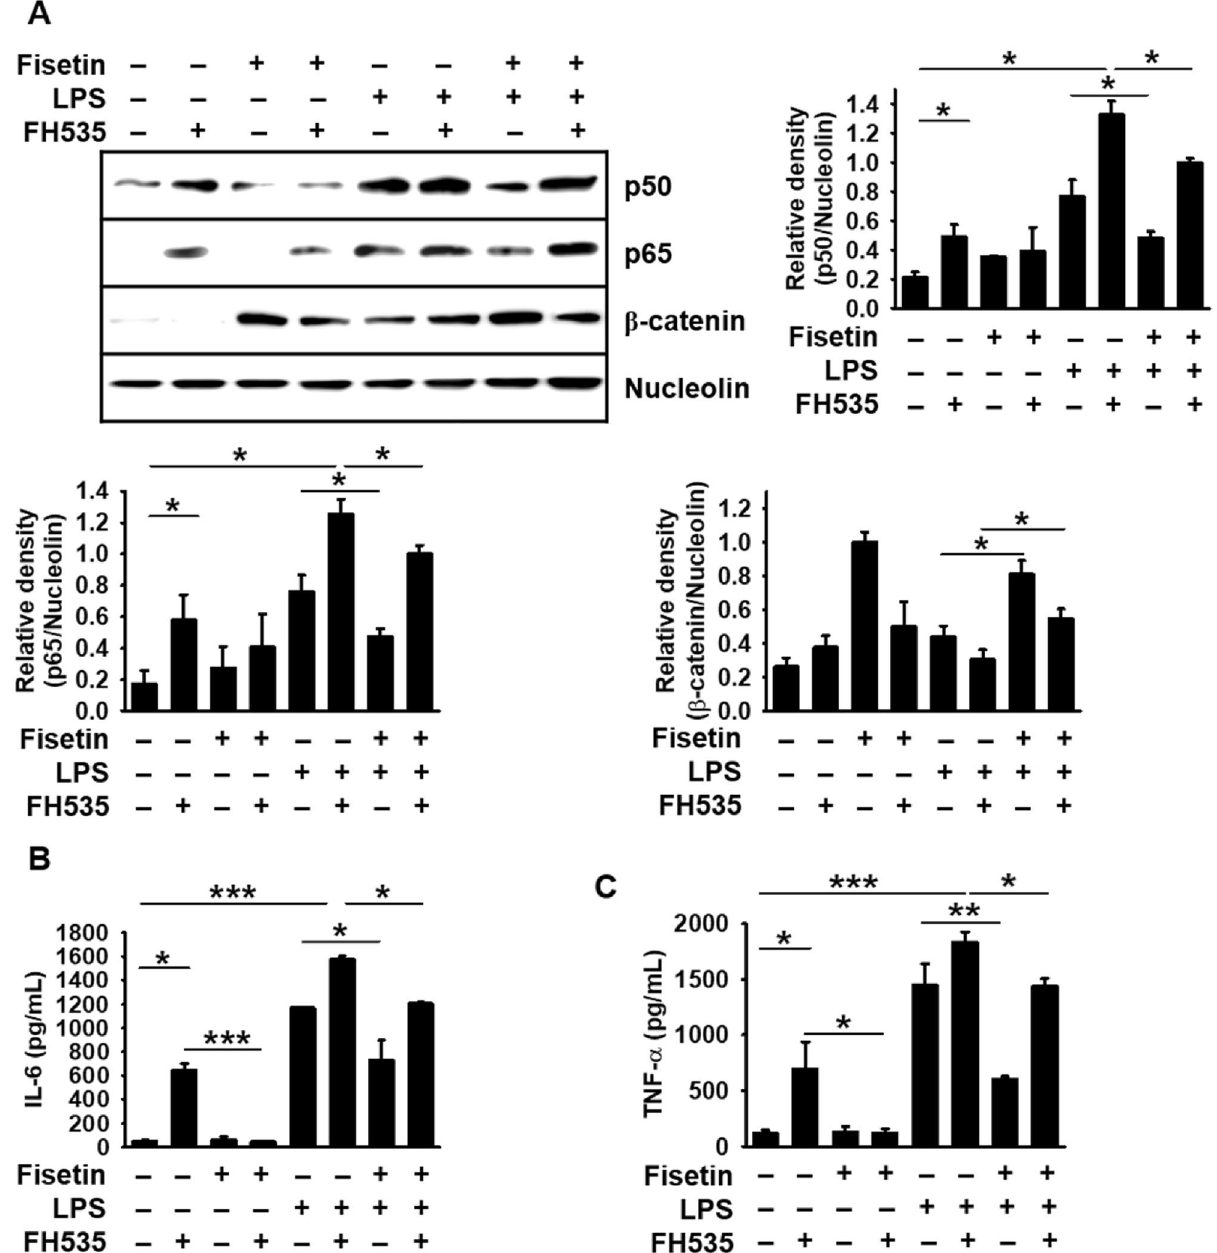
Figure 7. Fisetin inhibits LPS- or FH535-mediated IL-6 and TNF-α release by stimulating β-catenin-mediated NF-κB inactivation. RAW 264.7 macrophages (1 × 10 5 cells/mL) were incubated with 10 µM FH535 for 2 h prior to treatment with 8 μM fisetin and 500 ng/mL LPS. ( A ) Nuclear proteins were extracted and western blotting was performed with specific antibodies against p65, p50, and β-catenin. Nucleolin was used as an internal control. ( B , C ) In a parallel experiment, the culture supernatants were collected and extracellular levels of ( B ) IL-6 and ( C ) TNF-α were measured by ELISA. Each value indicates the mean ± standard error median (SEM), and is representative of the results obtained from three independent experiments. Significant differences among the groups were determined using one-way ANOVA with Bonferroni correction (*** p < 0.001, ** p < 0.005, and * p <